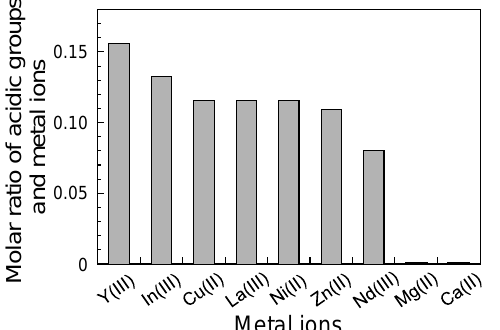
Figure 6. Molar ratios of acidic groups (sulfate and carboxylate groups) and metal ions. The amount of acid groups, such as the sulfate and carboxyl groups, in the fucoidan was determined by neutralization titration. The moles of the accumulated metal ions were estimated from the maximum-accumulated amount calculated from the assumed line in Figure